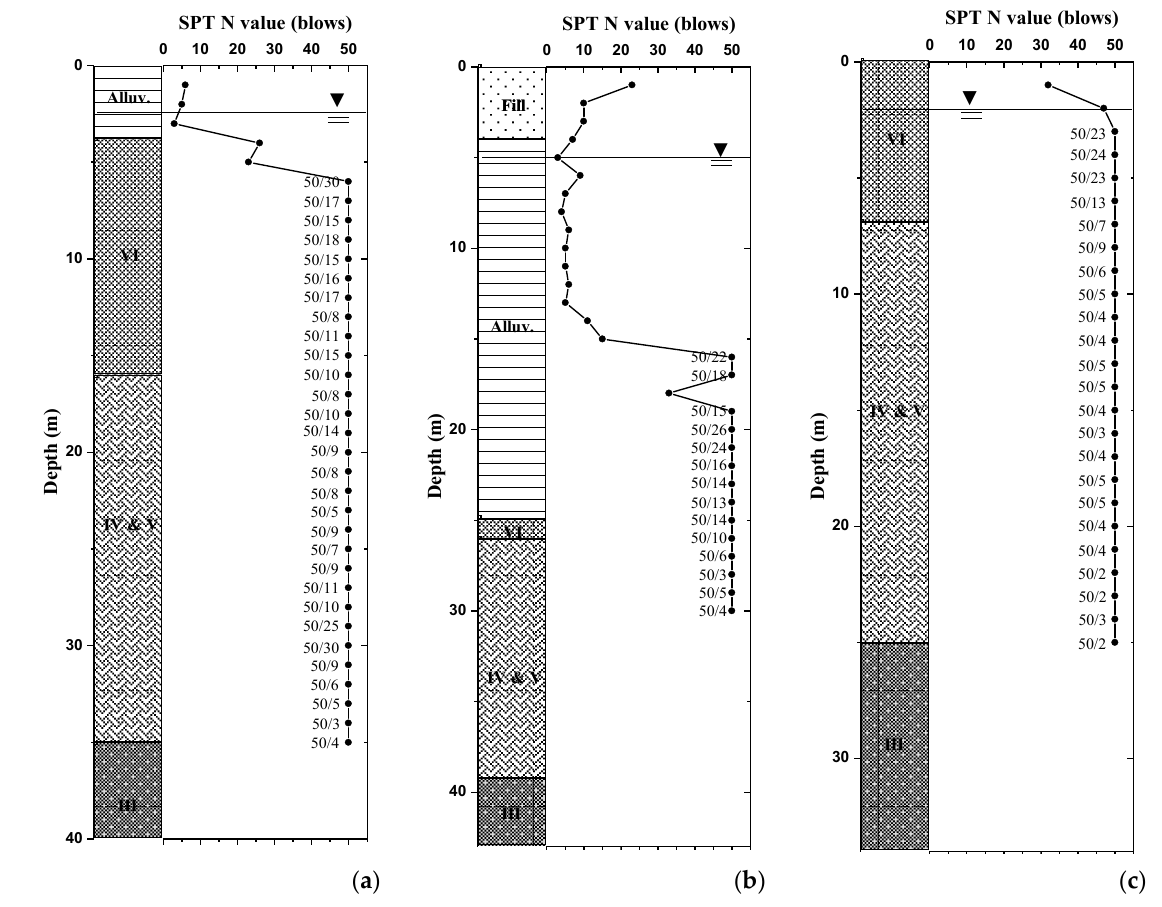
Figure 2. Boring logs of test sites: ( a ) A site; ( b ) G site; ( c ) S site.